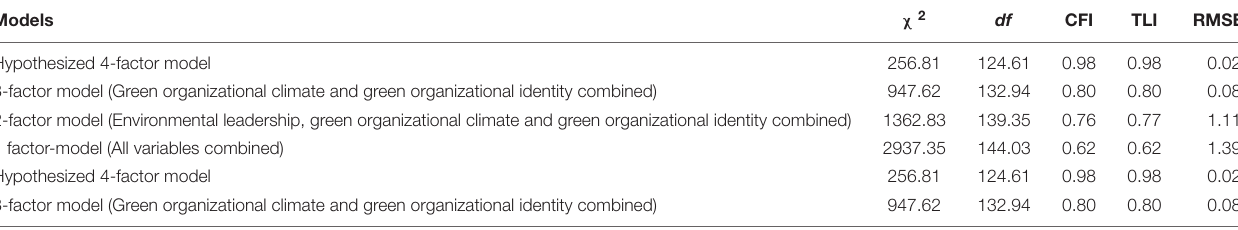
TABLE 2 | Means, standard deviations, and correlations of studied variables.